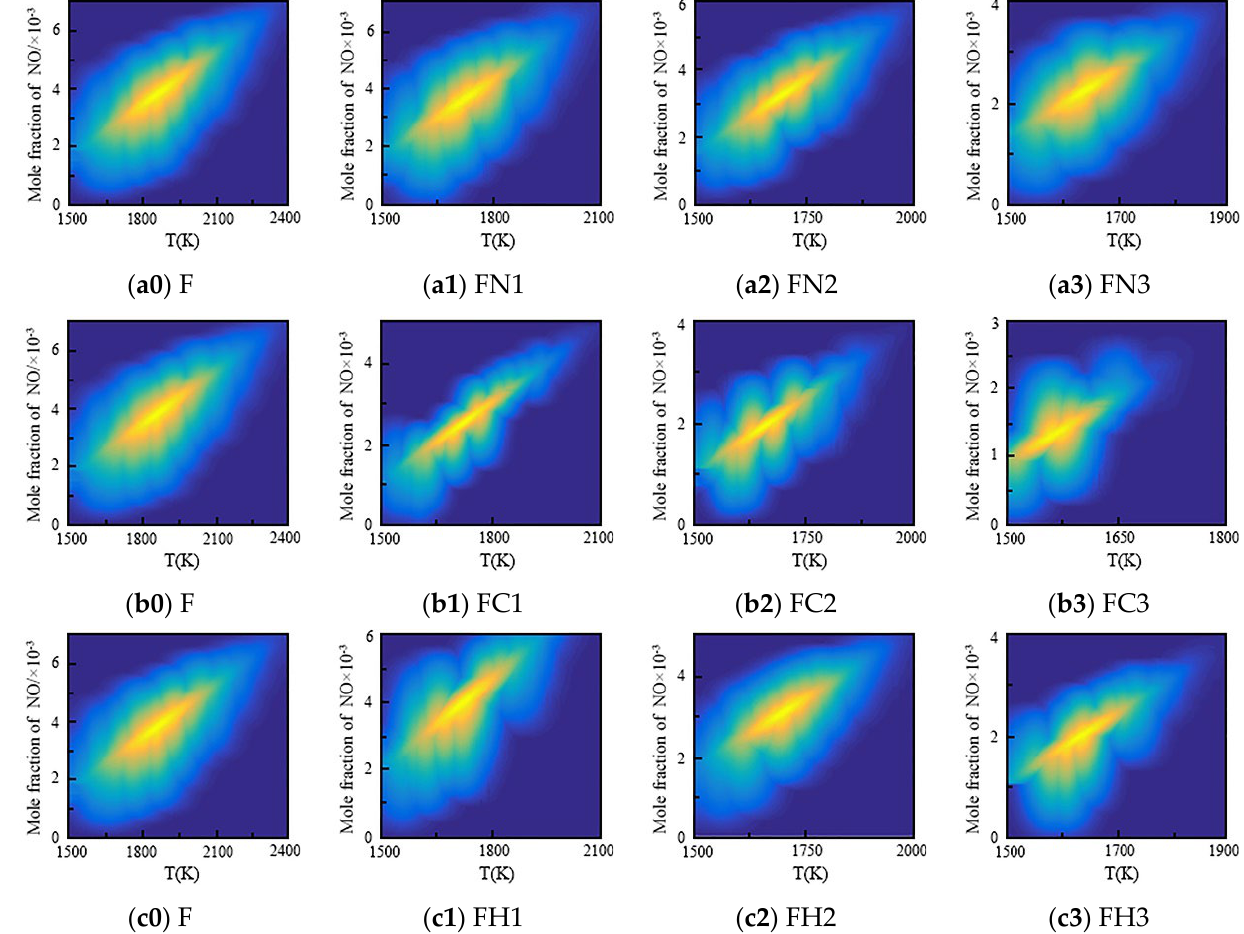
Figure 9. JPDFs of the temperature and NO concentration.